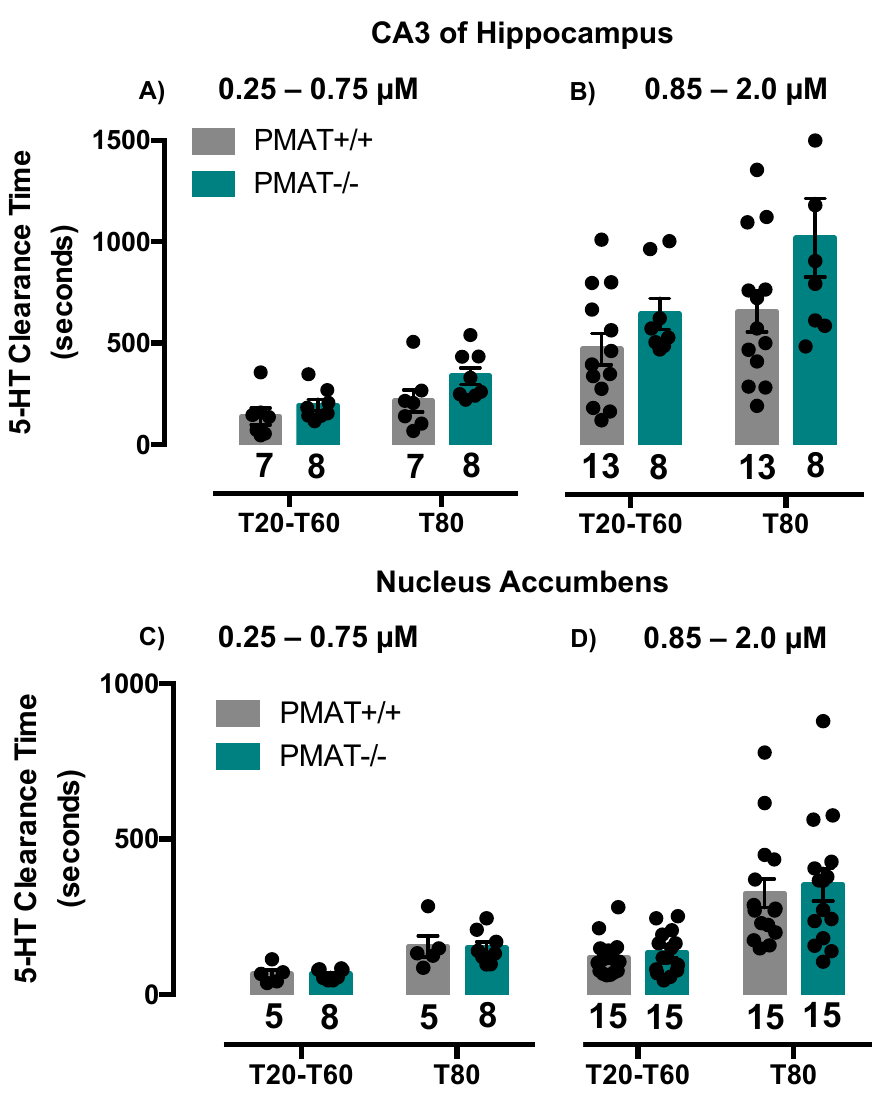
Figure 3. Serotonin clearance time (T 20 -T 60 and T 80 ) does not di ff er between PMAT +/+ and PMAT − / − mice, regardless of serotonin concentration. ( A ) There was no statistically significant di ff erence between PMAT +/+ and PMAT − / − mice in serotonin clearance time (T 20 -T 60 and T 80 ) in CA3 of hippocampus at “low” concentration of serotonin (0.25 µ M to 0.75 µ M) or ( B ) “high” concentrations of serotonin (0.85 µ M to 2.0 µ M). ( C ) There was no statistically significant di ff erence between PMAT +/+ and PMAT − / − mice in serotonin clearance time (T 20 -T 60 and T 80 ) in nucleus accumbens at “low” concentration of serotonin (0.25 µ M to 0.75 µ M) and ( D ) “high” concentrations of serotonin (0.85 µ M to 2.0 µ M). Note that the ordinates di ff er between CA3 region of hippocampus (panels A and B), and NAcc (panels C and D). Circles represent individual mice. Data are as mean ± S.E.M.